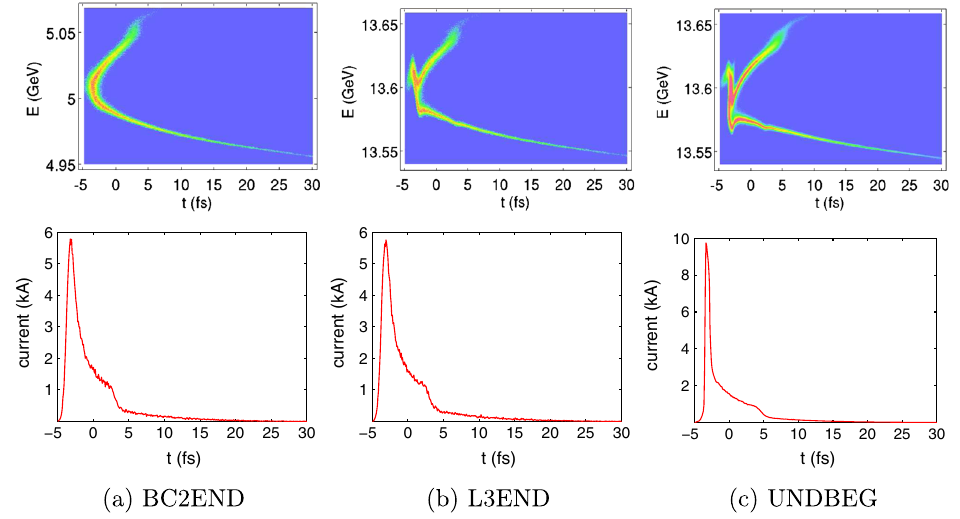
FIG. 3. E LEGANT tracking results of electron bunch distribution in the longitudinal phase space (upper) and its current profile (lower) at the BC2 end (a), the L3 end (b), and the LCLS undulator entrance (c). The L1S rf phase is − 27 °. L1X is with the rf phase of − 180 ° and amplitude of 15 MV. The L2 rf phase is − 34 . 9 °.